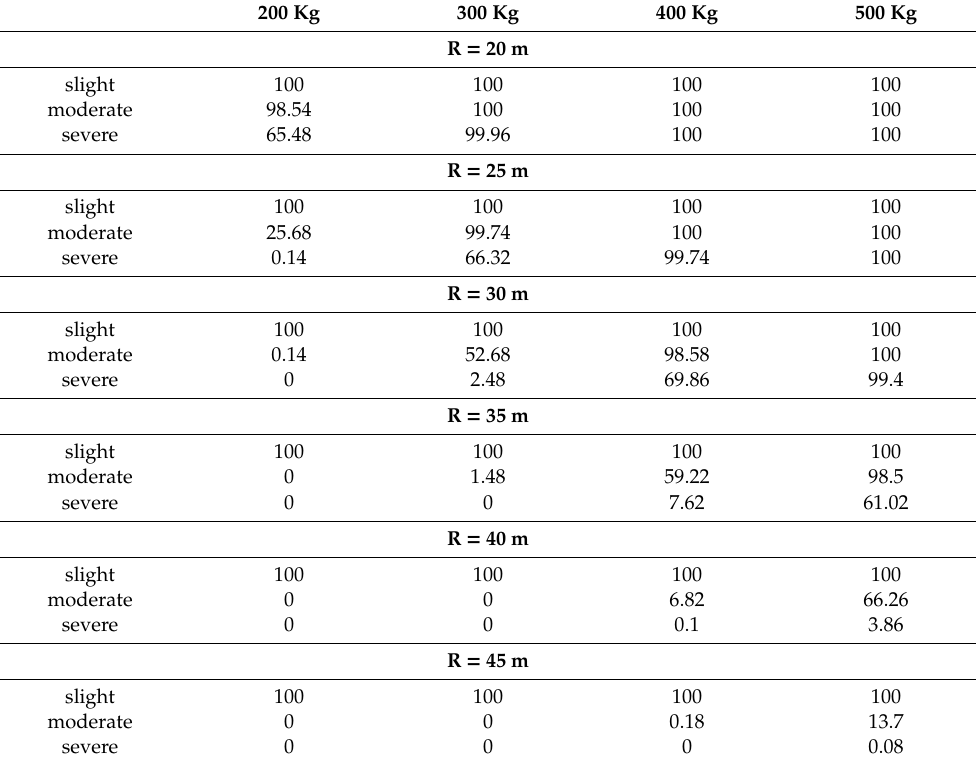
Table 8. Percentage probability of thresholds exceedance for Catania